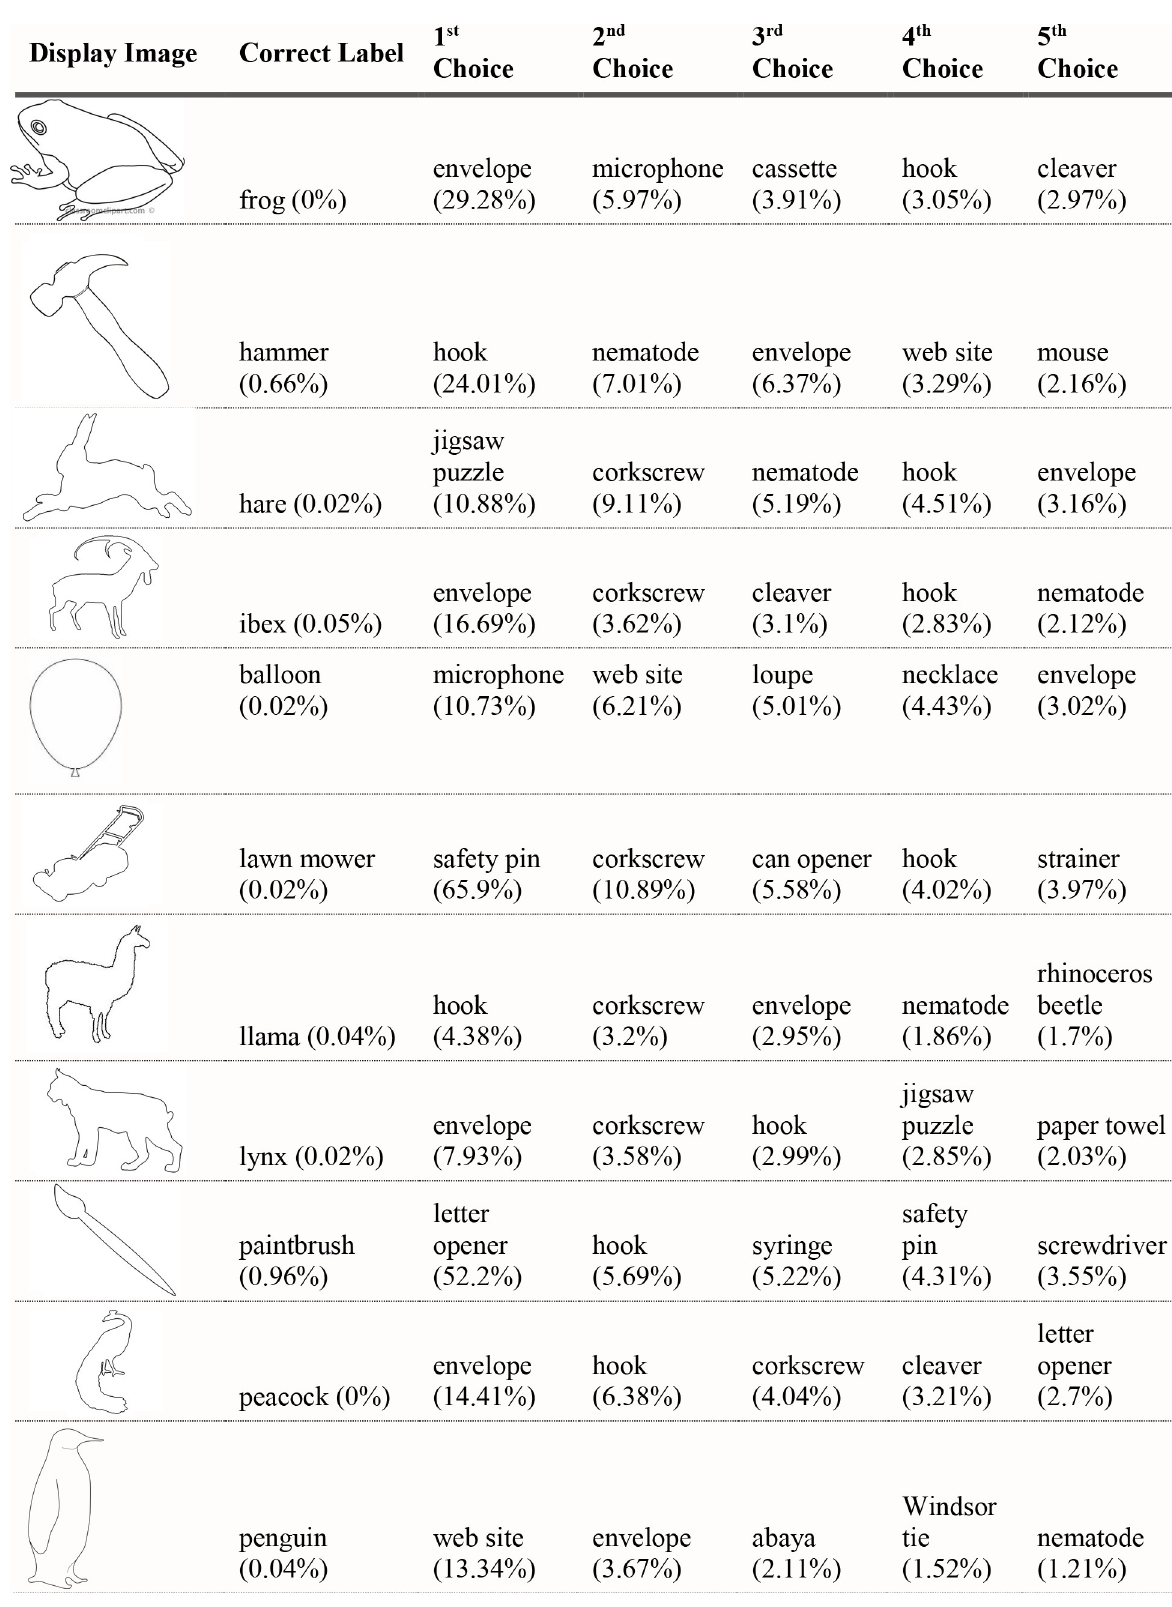
Fig 15. VGG-19 classifications for object outlines Part 2.